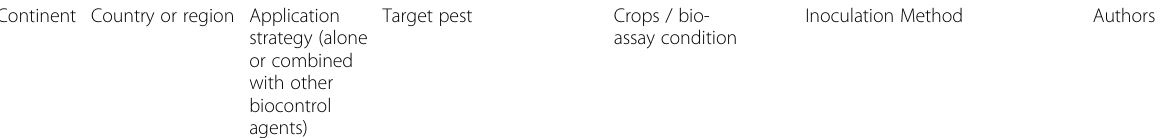
Table 1 Summary of the control programs that successfully used Beauveria bassiana for crop protection from 2009 to 2019